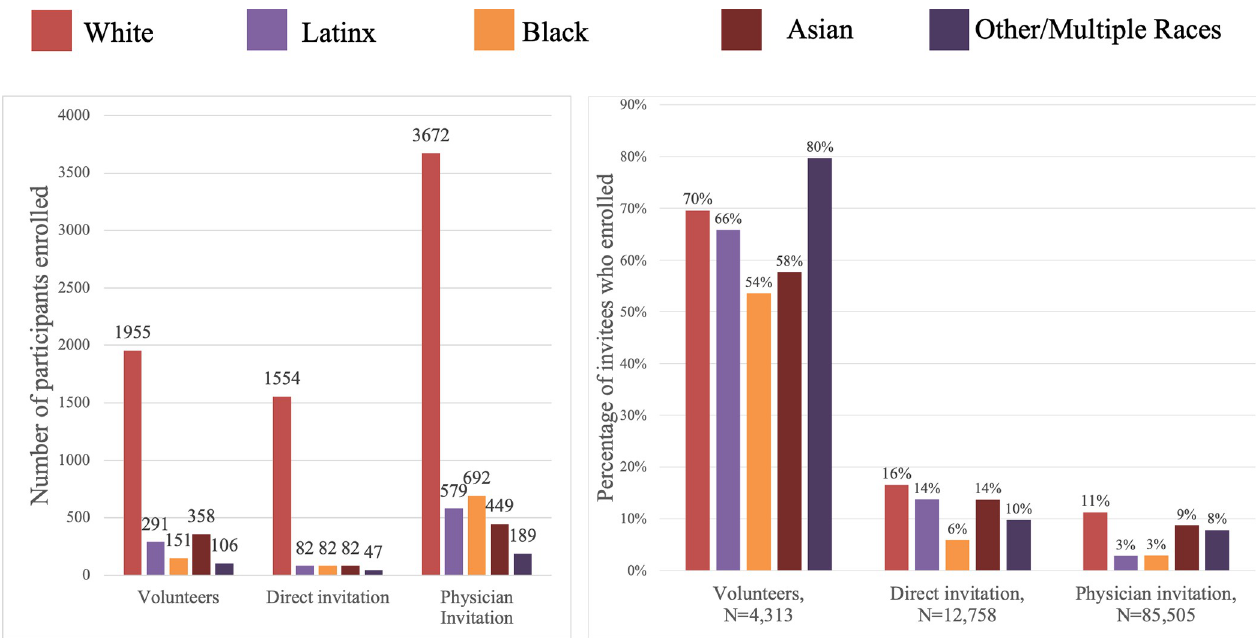
Fig 3. Enrollment by recruitment method. LEFT PANEL: Number of participants enrolled by recruitment method (Total enrolled cohort N = 10,289) RIGHT PANEL: Percent of invitees who accepted an invitation to enroll, by recruitment method (Total invited N = 102,576).